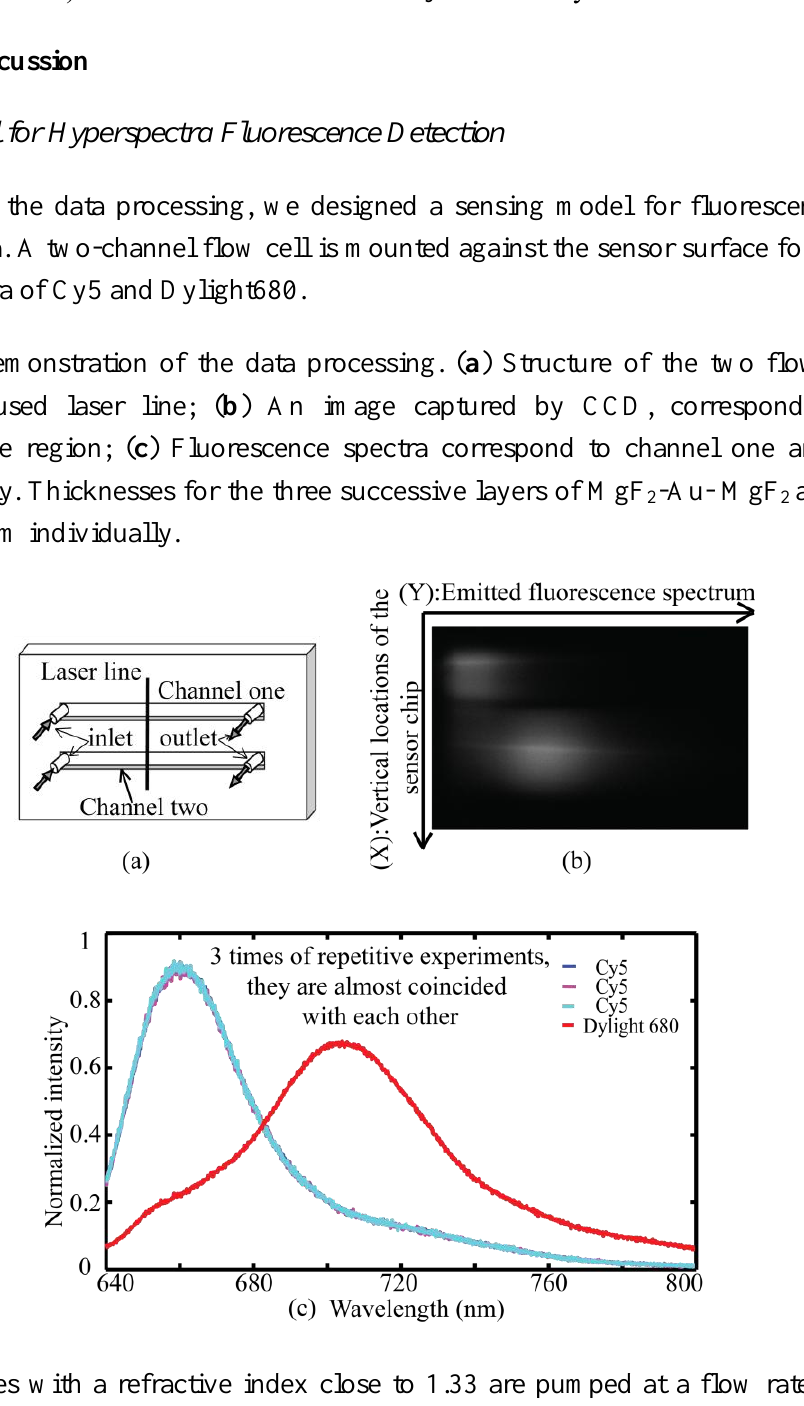
-Au- MgF are 500 nm, 2 2